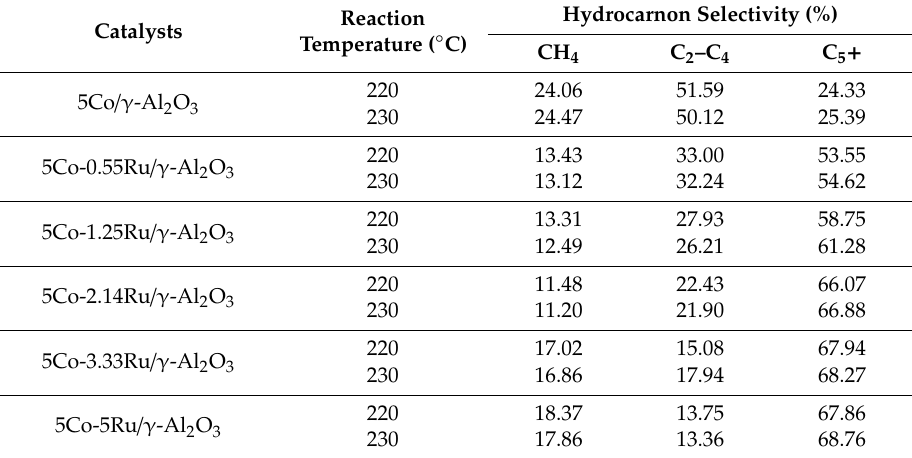
Table 2. FTS product distributions achieved with various synthesized catalysts [85]. Catalysts